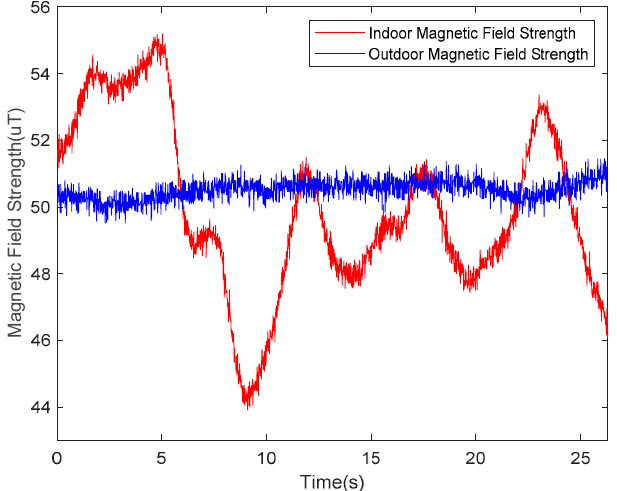
Figure 2. The measurements of the geomagnetic field. The red line is obtained indoors, and the blue line is obtained outdoors.